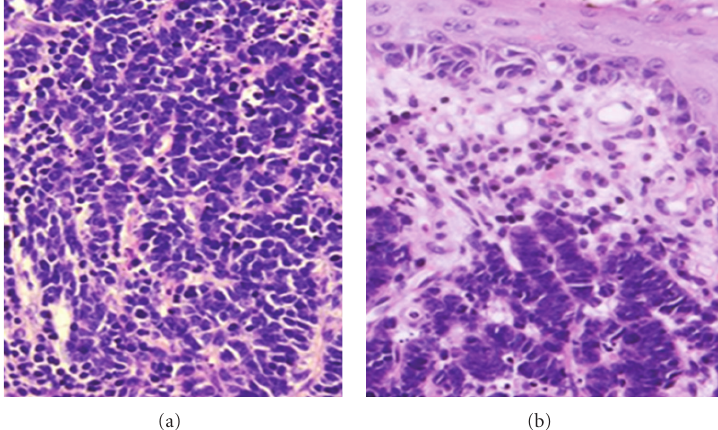
Figure 1: Histologic section of the inguinal lymph node (a) and anal canal lesion (b) demonstrating small to intermediate malignant cells with little cytoplasm, nuclear molding, necrosis, and apoptosis. Both showed positive immunoreactivity for keratin AE1/3, synaptophysin and were negative for p63 (H&E 400x).